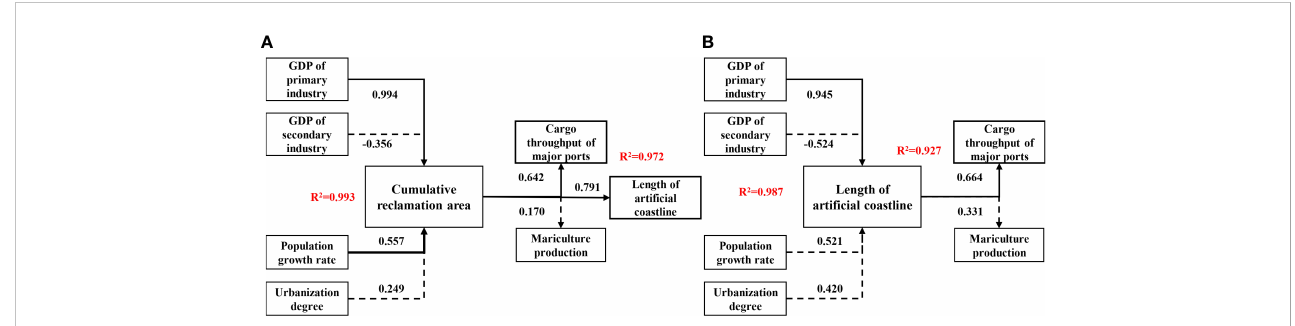
FIGURE 9 Path analysis to estimate the reclamation (A) and arti fi cial coastline (B) and relationships between socio-economic factors. Numbers show the standardized betas of the regression equations. Solid lines indicate that the effect is signi fi cant; dotted lines indicate that the effect is insigni fi cant. The R 2 for all the equations was high and ranged between 0.927 and 0.993, indicating good performance.